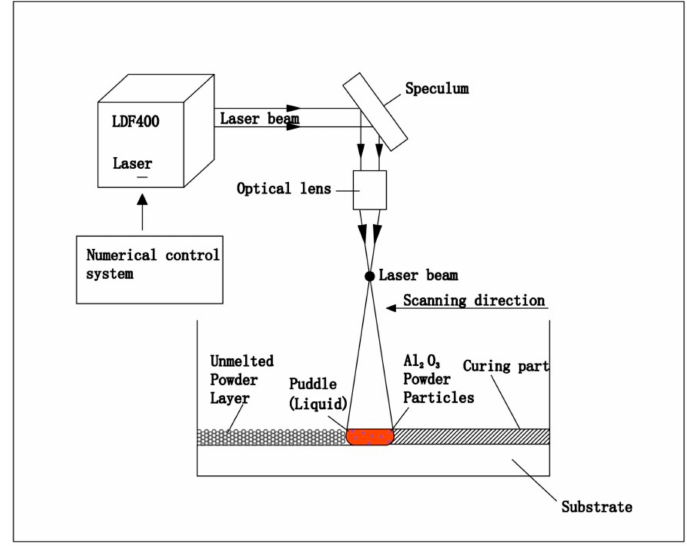
Figure 6. Diagram of laser melting